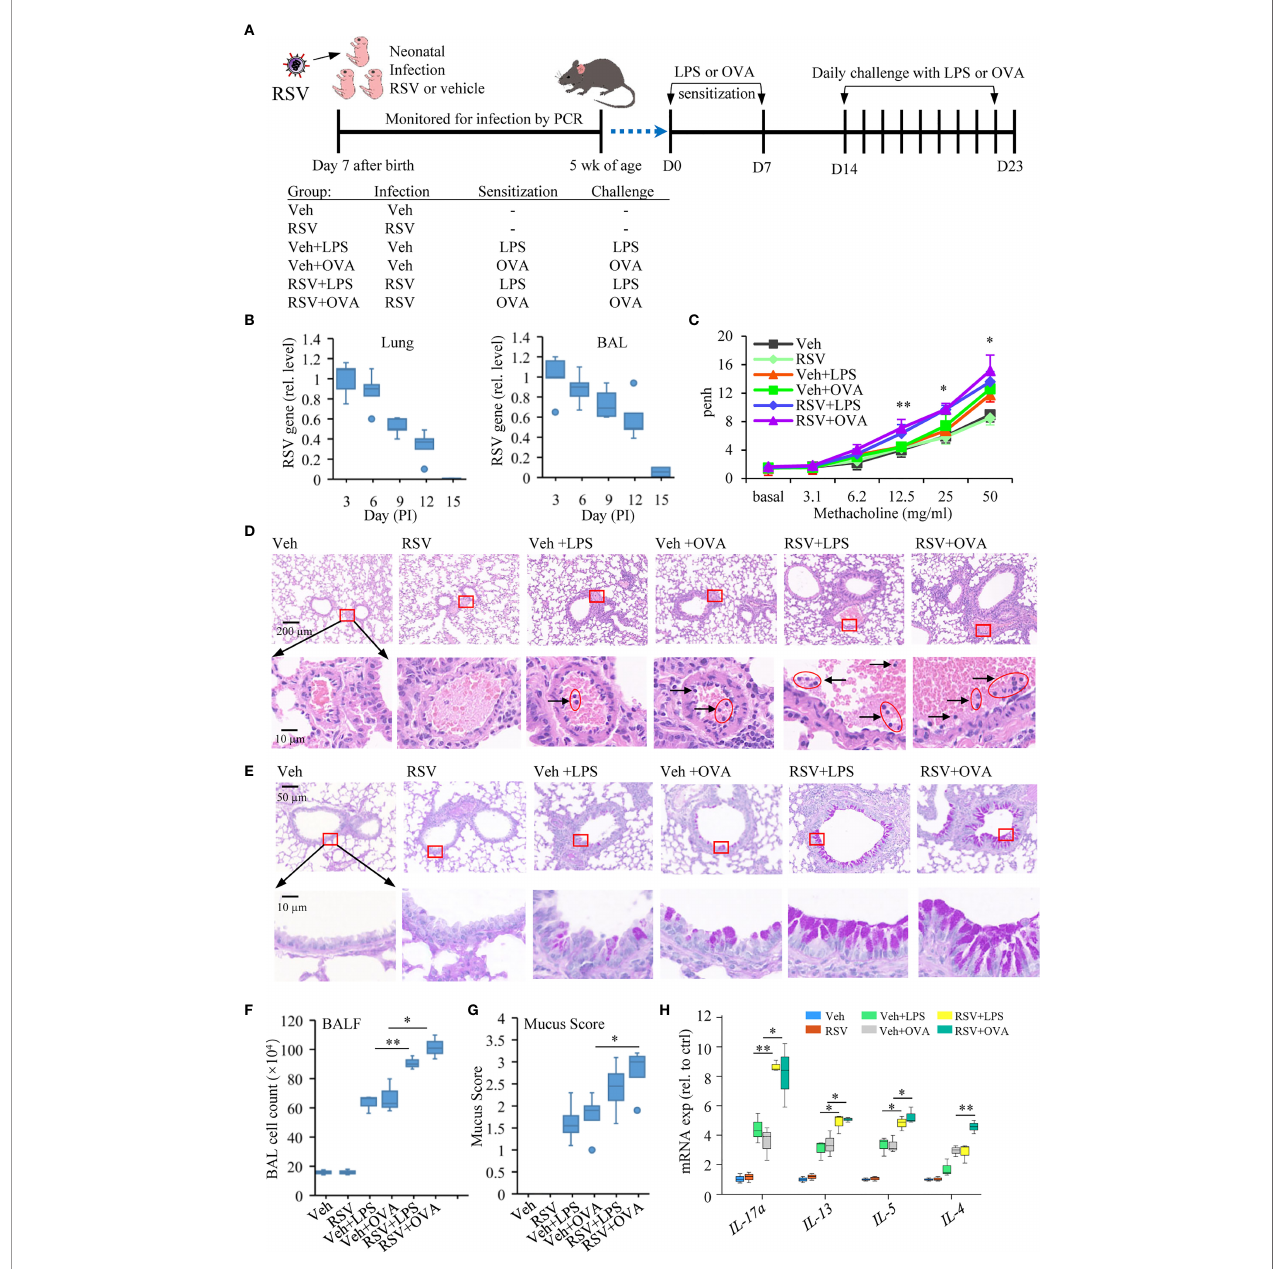
FIGURE 1 | Early-life infection with RSV aggravates lung allergic pathology. (A) Schematic diagram and treatment regimens of experimental model of induced asthma after early-life RSV infection. Mice were infected with RSV or with a vehicle (Veh, DMEM containing 2% FBS) at 7 days of age and secondary allergen challenge initiated at 4 weeks postinfection on D0 and D7. The mice were left untreated or subjected to daily challenge with aerosolized LPS or OVA for 9 consecutive days (30 min each day). (B) RSV nucleocapsid gene expression was quanti fi ed in the respiratory tract (lung; BAL, cell fraction) by RT-qPCR from the day of infection until the virus is undetectable. (C) Airway responsiveness of mice was evaluated by Penh, which is an indicator of bronchoconstriction. The data were collected in response to gradient concentration (0, 3.1, 6.2, 12.5, 25, and 50 mg/ml) of inhaled MCh. The three sets of asterisks from left to right are RSV+OVA vs. Veh+OVA, RSV+LPS vs. Veh+LPS, and RSV+OVA vs. Veh+OVA. (D) Images show representative HE-stained sections from Veh-, RSV-, Veh+LPS-, Veh+OVA-, RSV+LPS-, and RSV+OVA-treated groups. The accumulation of lymphocytes in the small blood vessels around the bronchus was observed in H&E staining, which is enlarged and shown in the picture below. The scale bar is 200 m m (the upper picture) and 10 m m (the lower picture). (E) PAS staining was performed to detect mucus production (bright purple staining) in bronchial goblet cells. The lower picture is an enlarged view of the area inside the box in the upper picture. The scale bar is 50 m m (the upper picture) and 10 m m (the lower picture). (F) Total cell numbers in BALF were analyzed to evaluate the degree of airway in fl ammation. (G) Subjective mucus scoring was performed on blinded histological slides on a scale of 1 – 4 for mucus production ( n = 3). (H) Gene expression including IL-4 , IL-5 , IL-13 , and IL-17a in the lung tissues measured by RT-qPCR ( n = 3). Statistical results are shown: * p < 0.05 and ** p <